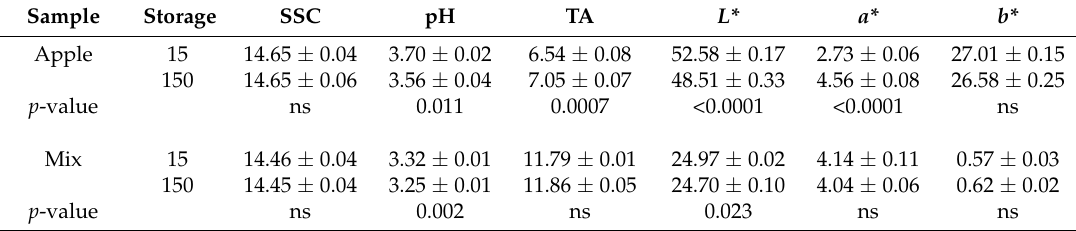
Table 2. Physicochemical parameters: pH, soluble solids content (SSC, g/100 g), titratable acidity